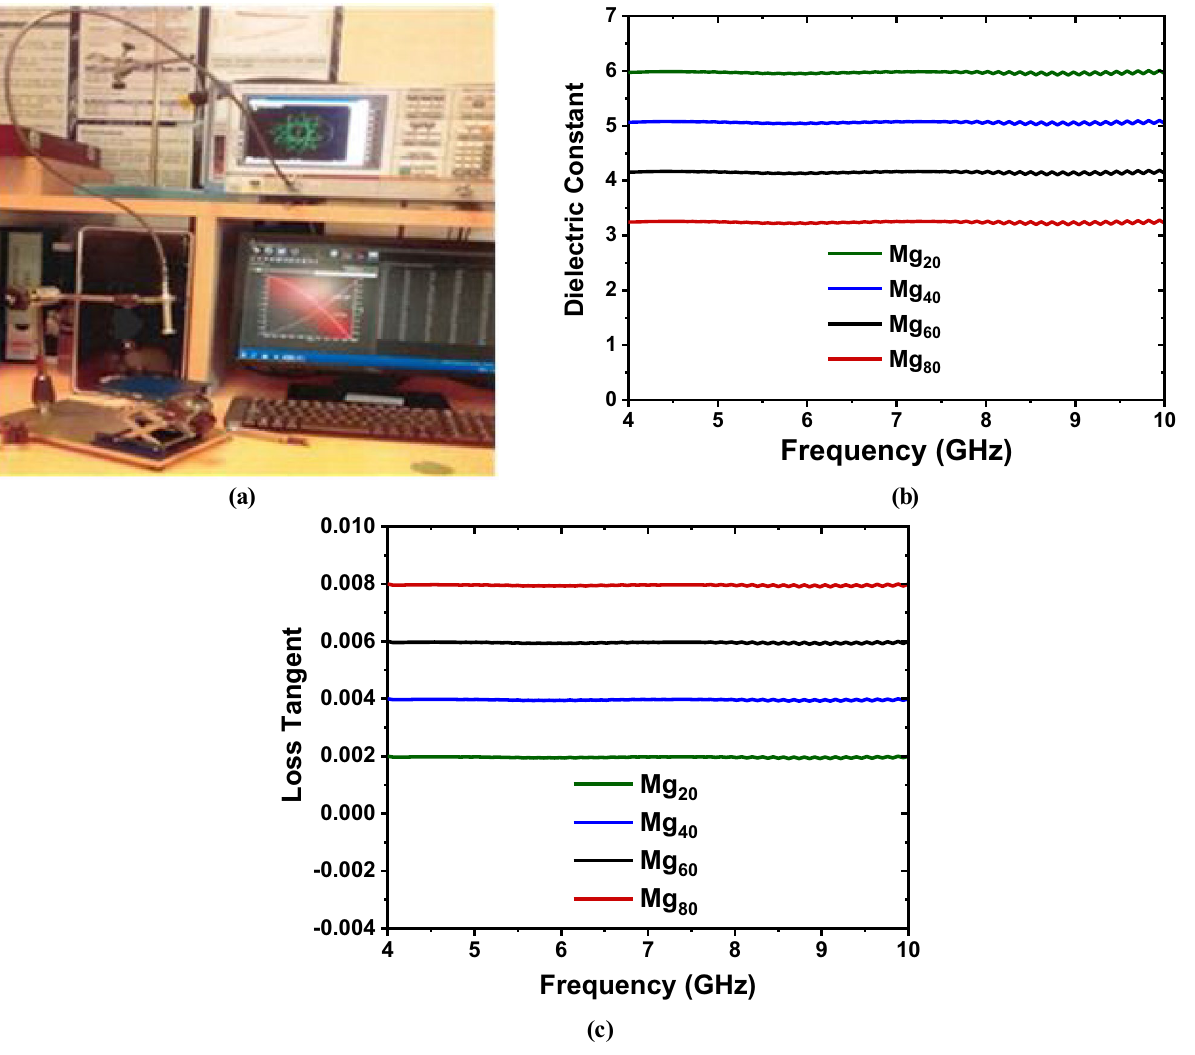
Figure 10. ( a ) Dielectric measurement setup with DAK 3.5 kit, ( b ) Dielectric constant, and (c) Loss tangent (T δ ) over